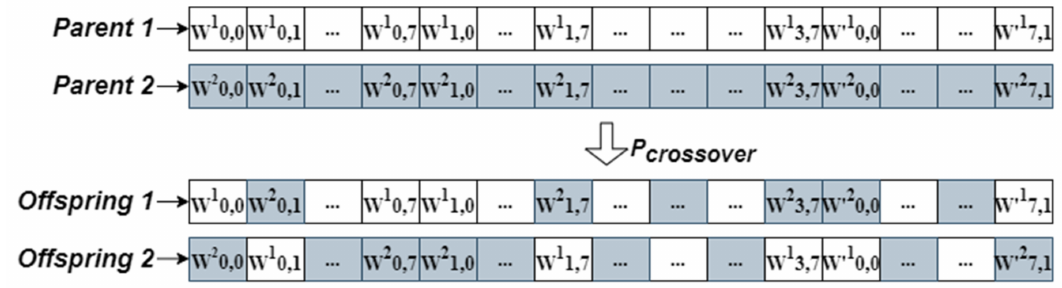
Figure 4. Uniform crossover, with P crossover